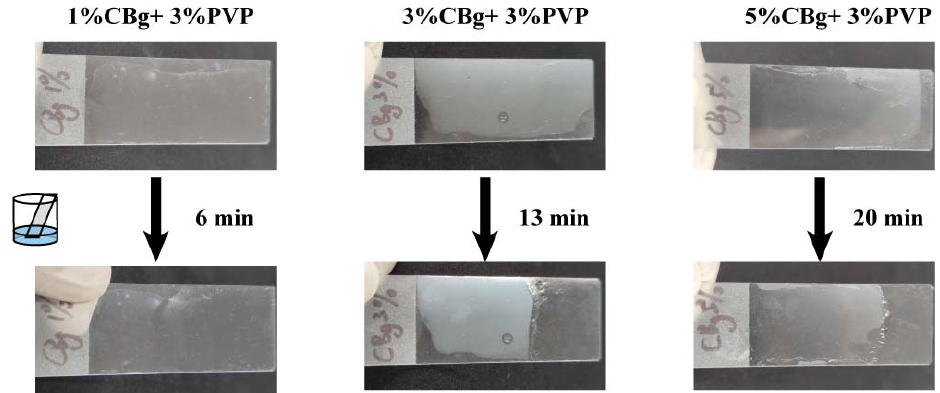
Figure 4. The times for CBg/PVP films with different mass concentrations to separate them from the glass in stirred water.